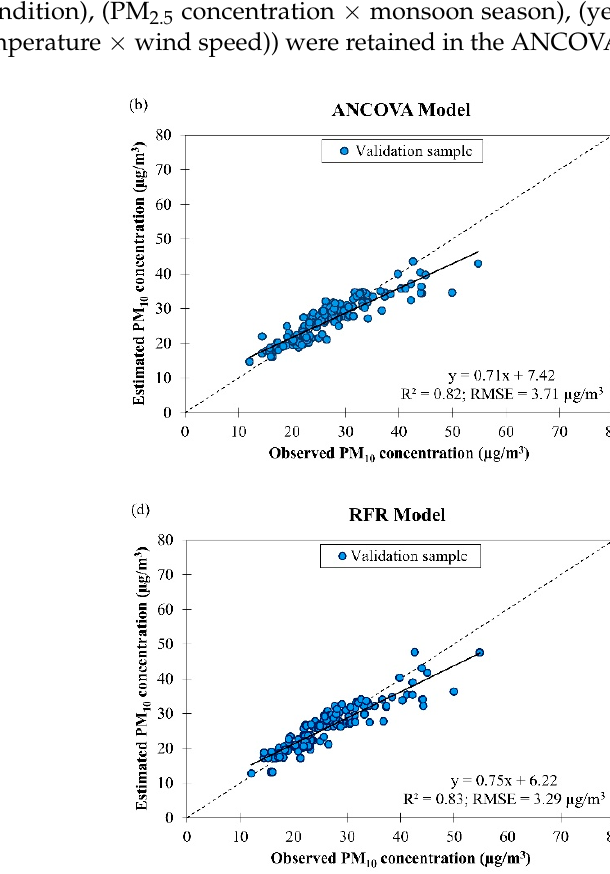
Figure 9. Scatter plots of estimated daily PM 10 concentration against observed daily PM 10 concentra- tion in Singapore from March 2016 to February 2018 by ( a , b ) ANCOVA and ( c , d ) RFR models with learning and validation